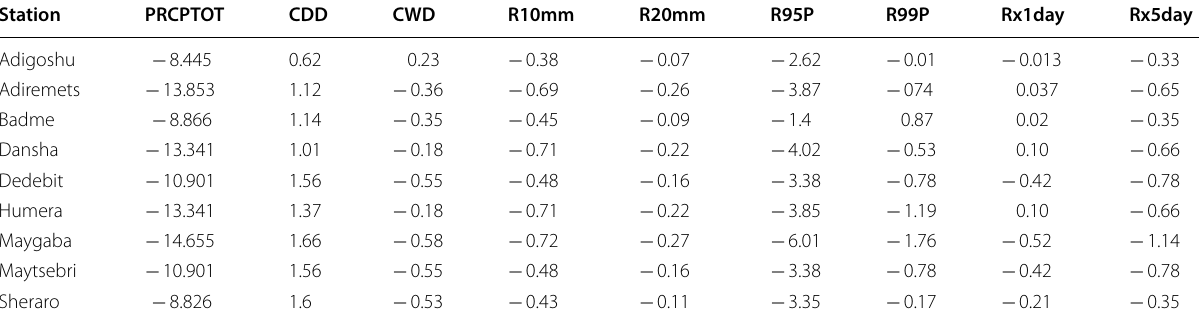
Table 4 Trends of extreme rainfall indices of nine locations in Western Tigray from 1983 to 2016 Station